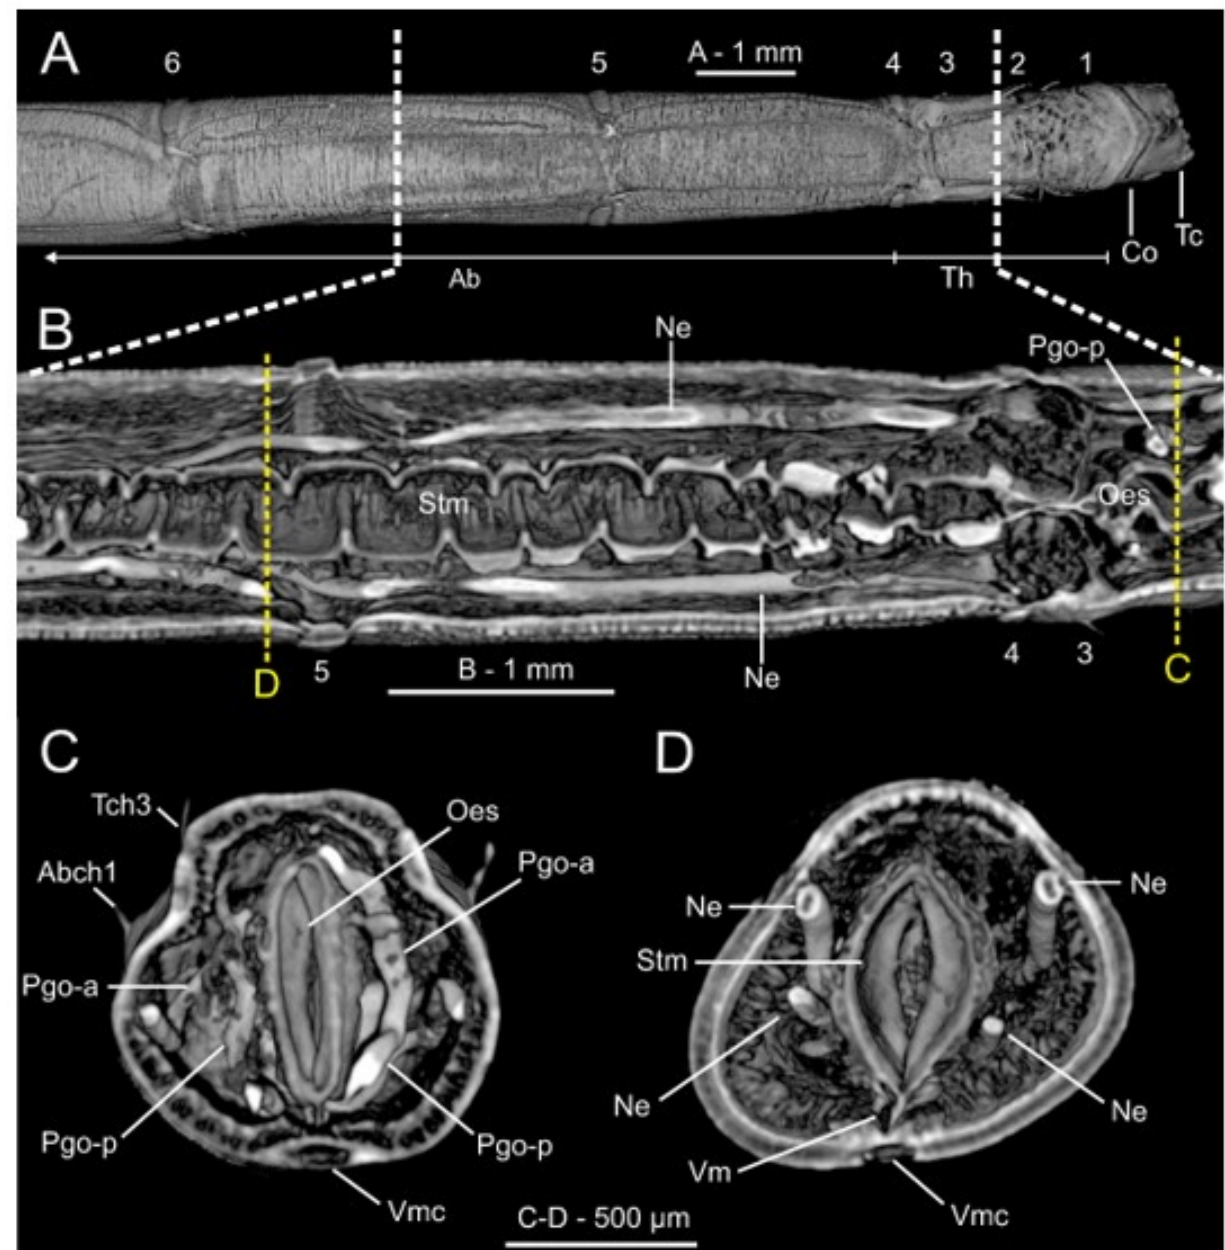
Figure 20. Micro-computed tomography ( µ CT) sections of Owenia fusiformis (MNCN 2866). ( A ) Dorsal view of body surface, ( B ) frontal and ( C – D ) transversal body sections showing internal anatomy. White discontinuous lines in ( A ) marking body region showed in ( B ). Yellow discontinuous lines in ( B ) marking position of transversal sections in ( C ) and ( D ) respectively. Chaetigers number provided. Abbreviations: Ab—abdomen, Abch1—abdominal chaetiger 1, Co—collar, Lml—longitudinal muscle layer, Ne—nephridial sac, Oes—oesophagus, Pgo-a/p—parapodial glandular organ—anterior/posterior, Stm— stomach, Tc—tentacular crown, Tch3—thoracic chaetiger 3, Th—thorax, Vm—ventral mesentery, Vmc—ventral medullary cord. Numbers indicate